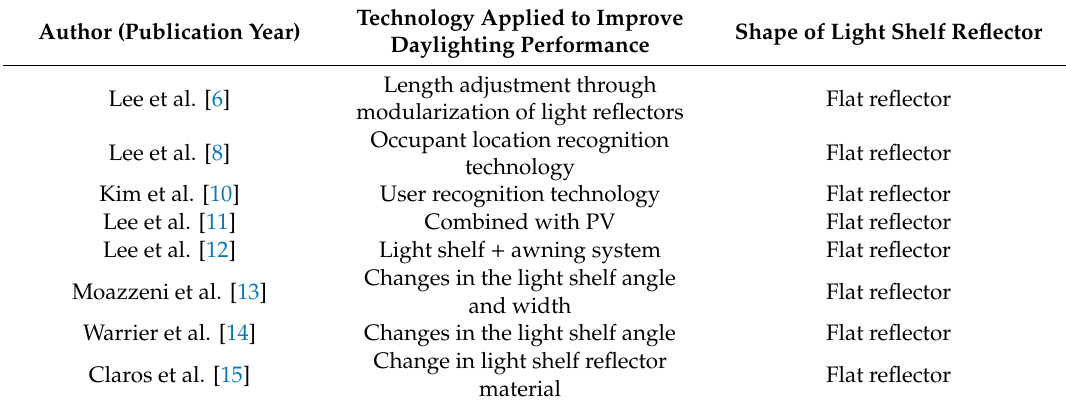
Table 1. Previous studies on light shelves for improving daylighting performance and reducing the energy consumption of the building.